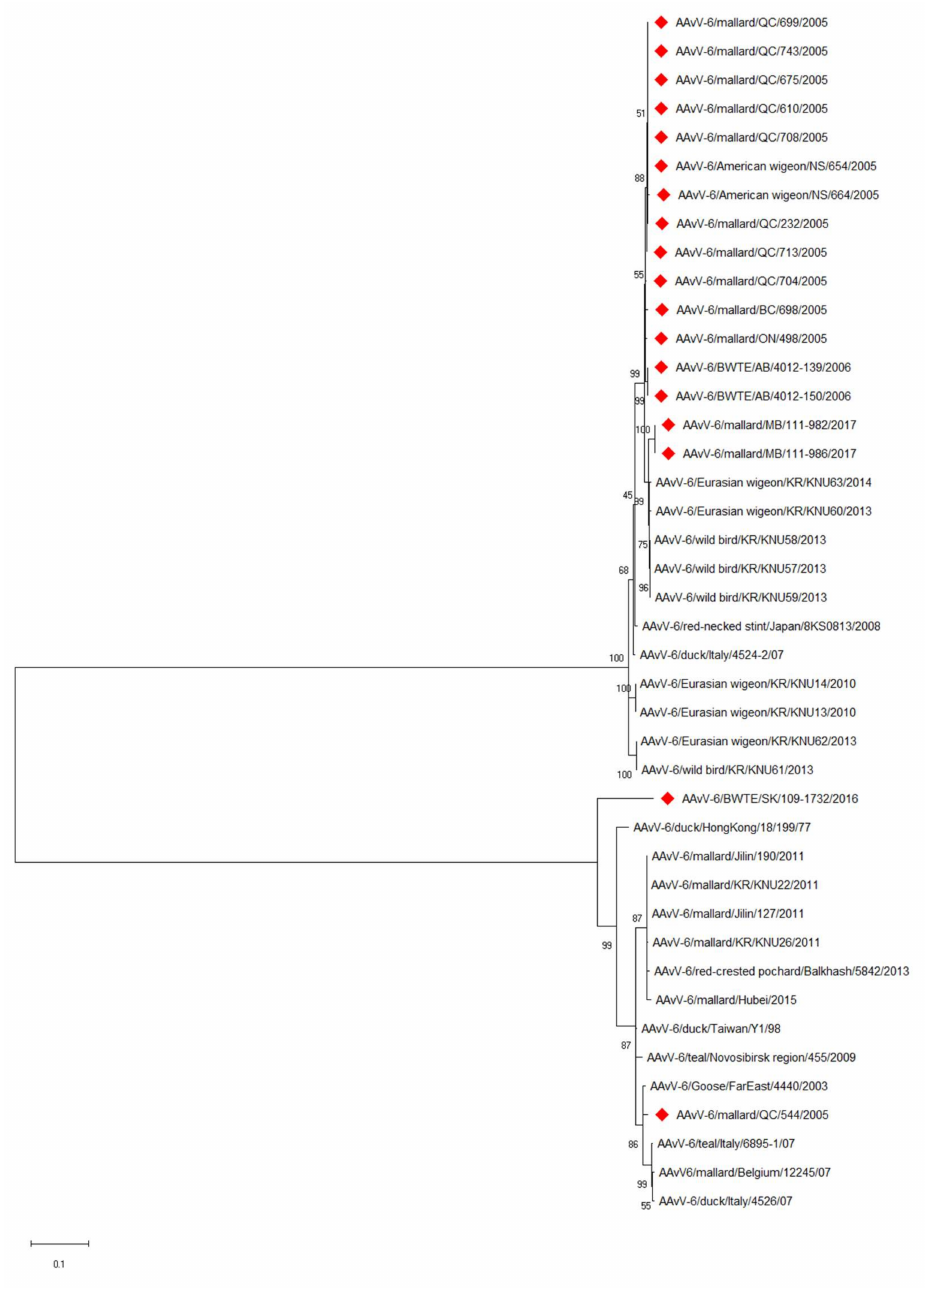
Figure 2. Phylogenetic analysis of the fusion gene sequences of AAvV-6 viruses. Viruses described in this study are denoted by red diamonds. The evolutionary history was inferred by using the Maximum Likelihood method based on the General Time Reversible model. The tree with the highest log likelihood ( − 6759.79) is shown. The percentage of trees in which the associated taxa clustered together is shown next to the branches. Initial tree(s) for the heuristic search were obtained automatically by applying Neighbor-Join and BioNJ algorithms to a matrix of pairwise distances estimated using the Maximum Composite Likelihood (MCL) approach, and then selecting the topology with superior log likelihood value. A discrete Gamma distribution was used to model evolutionary rate differences among sites (5 categories (+ G , parameter = 0.5780)). The rate variation model allowed for some sites to be evolutionarily invariable ([+ I ], 31.74% sites). The tree is drawn to scale, with branch lengths measured in the number of substitutions per site. The analysis involved 42 nucleotide sequences. There were a total of 1668 positions in the final dataset. Evolutionary analyses were conducted in MEGA